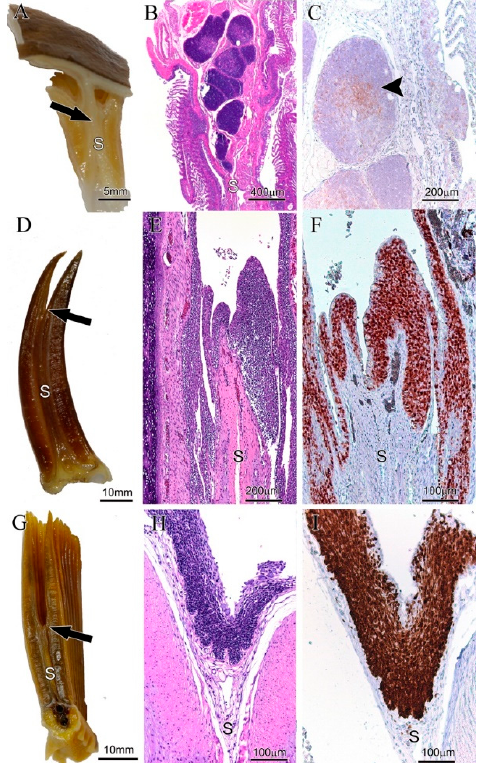
Figure 4. Gill-associated lymphoid tissue (GIALT) of Chondrichthyes and Actinopterygi. All images were taken from the second left gill arch and oriented in the transversal plane of the gill. ( A–C ) Catshark ( S. hesperius ). ( A ) Macroscopic image of a dissected gill. Note that the interbranchial septum (S) is continuous with the hypodermis of the outer body surface. The black arrow points to the region as seen in images ( B , C ). ( B ) Staining of a transversal sectioned gill arch. Note the thymic tissue with cortex and medulla within the interbranchial septum. ( C ) Zap-70 staining of a thymic lobe. Note the high numbers of Zap-70+ cells (brown) within the medulla (black arrowhead). ( D–F ) Siberian sturgeon ( A. baerii ). ( D ) Macroscopic image of a dissected gill. Note the long but discontinued interbranchial septum (S). The black arrow points to the region as seen in images ( E , F ). ( E ) H&E staining of the epithelium lining the distal part of the interbranchial septum. ( F ) Zap-70 staining of the corresponding region shown in ( E ). Note the high numbers of Zap-70+ cells (brown) within the epithelium. ( G–I ) Bonefish ( Albula vulpes ). ( G ) Macroscopic image of a dissected gill. Note the intermediate length of the interbranchial septum (S). The black arrow points to the region as seen in ( H , I ). ( H ) staining of the epithelium lining the distal part of the interbranchial septum. ( I ) Zap-70 staining of the corresponding region shown in ( H ). Note the high numbers of Zap-70+ cells (brown) within the epithelium.